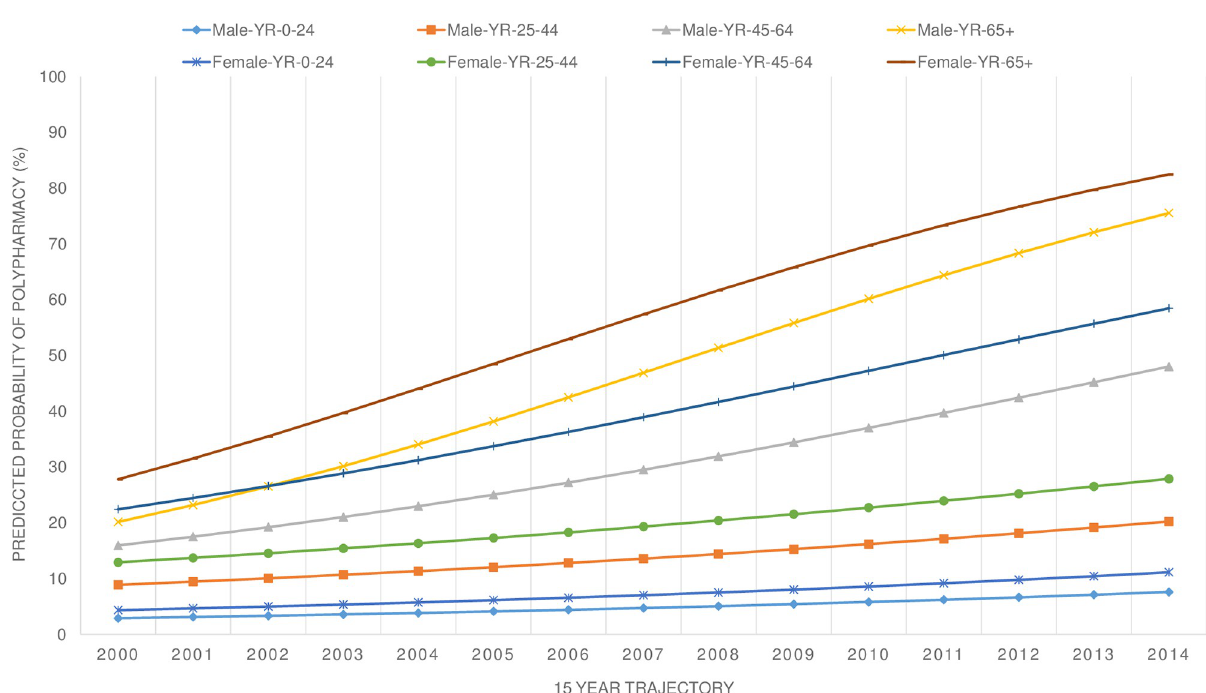
Fig 5. Predicted cumulative proportion of polypharmacy during 15-year trajectory stratified by sex and age.